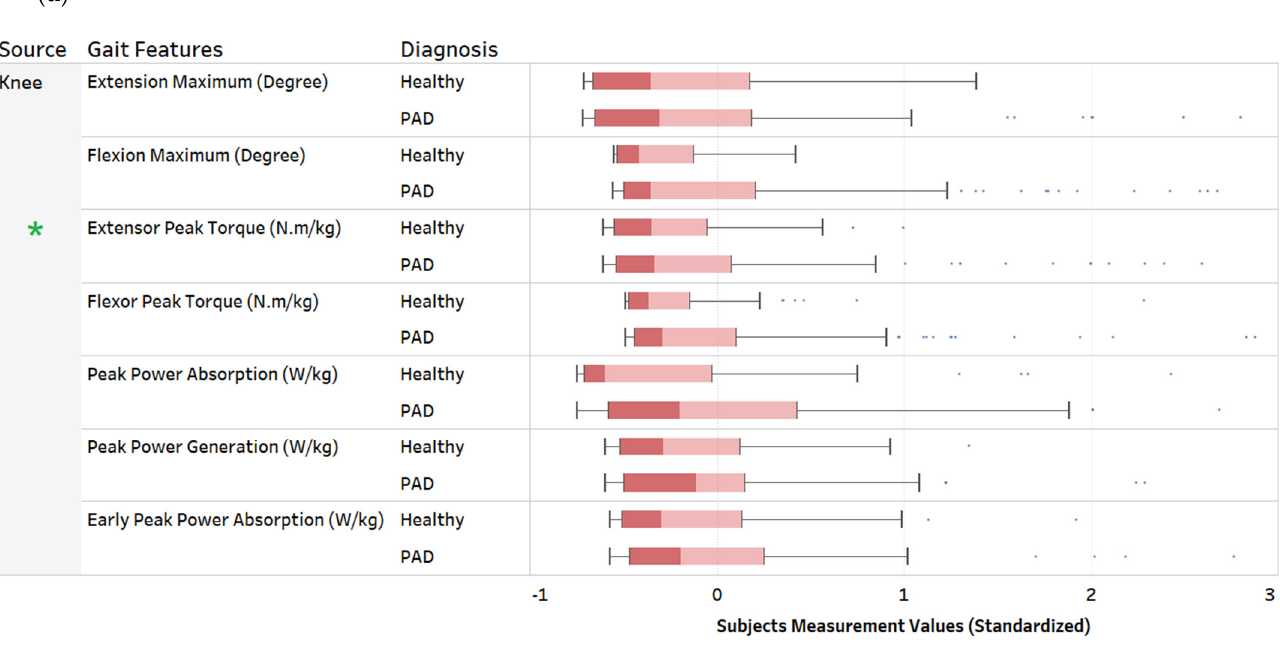
Levene’s Test for Homogeneity of Variance p -value Significance Level: * for p -value < 0.5, which indicates that the feature has a statically significant difference in variance. The x-axis shows box plot of the standardized values of gait feature. The y-axis shows the gait features as categories. Figure 2. Feature variance comparison of gait features between patients with PAD and healthy controls. ( a ) GRF gait features, ( b ) Ankle gait features, ( c ) Hip gait features, ( d ) Knee gait features. The green asterisks indicate a significant difference in variance based on Levene’s homogeneity of variance.